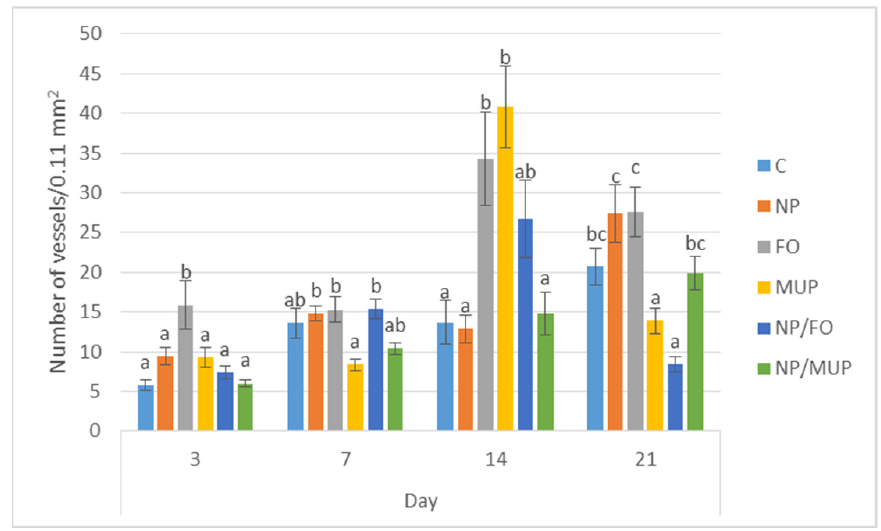
Figure 3. The semi-quantitative analysis of the extent of neoangiogenesis in the wound in the course of healing (3, 7, 14 and 21 days post-excision) using immunohistochemical labeling of vessels for alpha-smooth muscle actin. C—control (dressing alone); NP—dressing with empty poly(lactic- co-glycolic) acid (PLGA)-polyvinyl alcohol (PVA) nanoparticles (NPs); FO—dressing with fish oil; MUP—dressing with mupirocin; NP/FO—dressing with PLGA-PVA NPs with entrapped fish oil; NP/MUP—dressing with PLGA-PVA NPs with entrapped mupirocin. Mean ± SEM. a–c: different superscripts within a given time interval indicate a significant difference ( p < 0.05). One-way analysis of the variance ratio test with Tukey’s post hoc test.